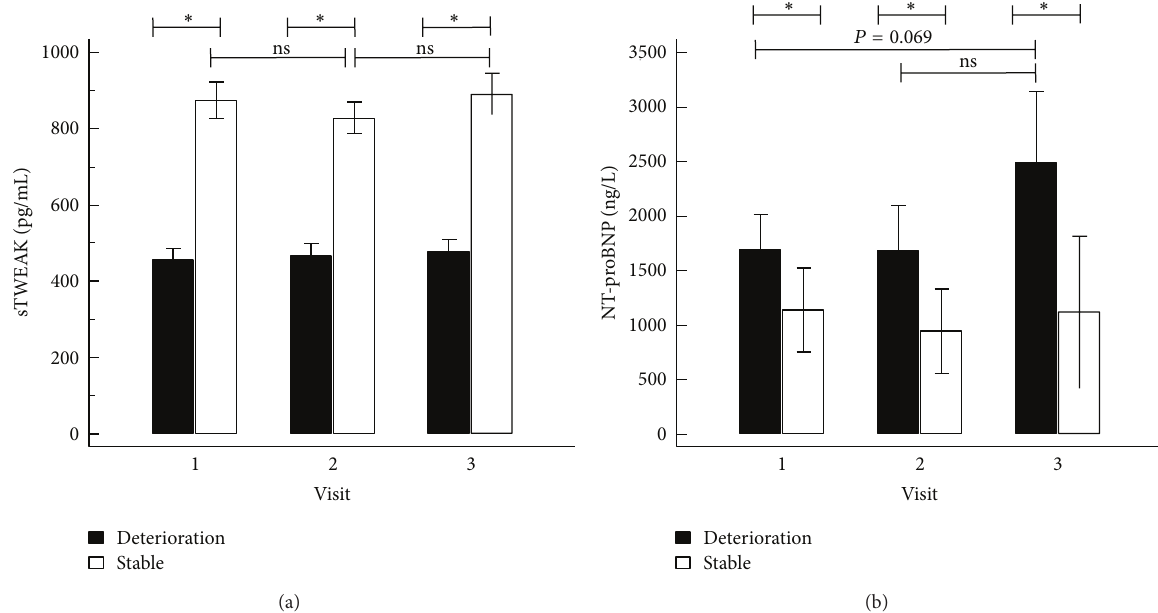
Figure 3: Interindividual differences in sTWEAK represent a risk factor for outcome in patients with dilated cardiomyopathy. To analyze the usefulness of sTWEAK as a biomarker in patients with dilated cardiomyopathy, we performed at least three serial sTWEAK measurements within all patients of our cohort. Interestingly, sTWEAK not only differed significantly between those patients with a progressive course of the disease and those with a stable course, but surprisingly remained very stable within individual patients with progressive deterioration, indicating that sTWEAK might represent a risk factor for disease progression rather than a biomarker for disease monitoring ( 𝑛 = 41 ; mean ± SEM; ∗ 𝑃 < 0.05